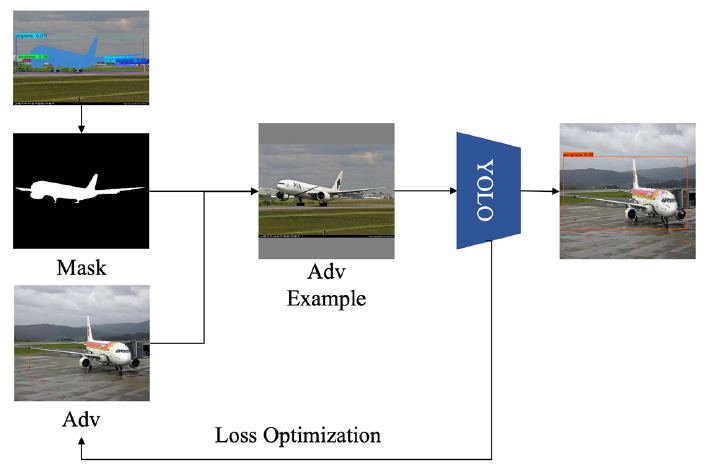
Figure 6. Restrained adversarial examples generation inside masks.